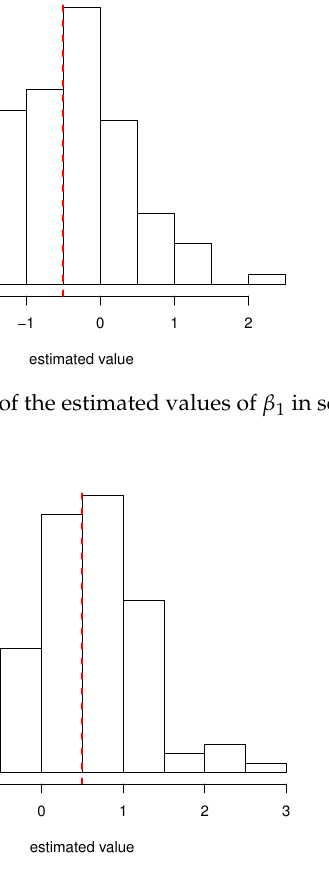
Figure 3. Histogram of the estimated values of γ 1 in setting (ii). The red dotted line represents the true